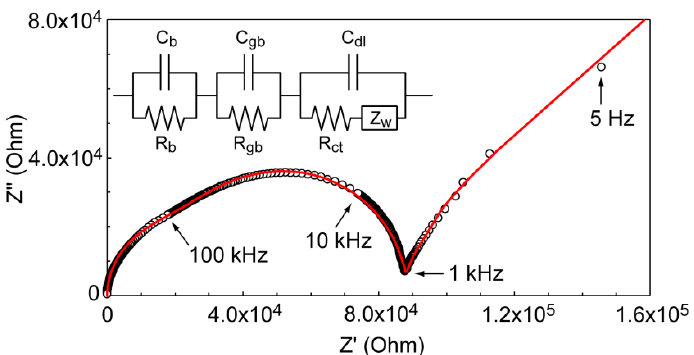
= 6.55 × 10 4 Ω, C gb